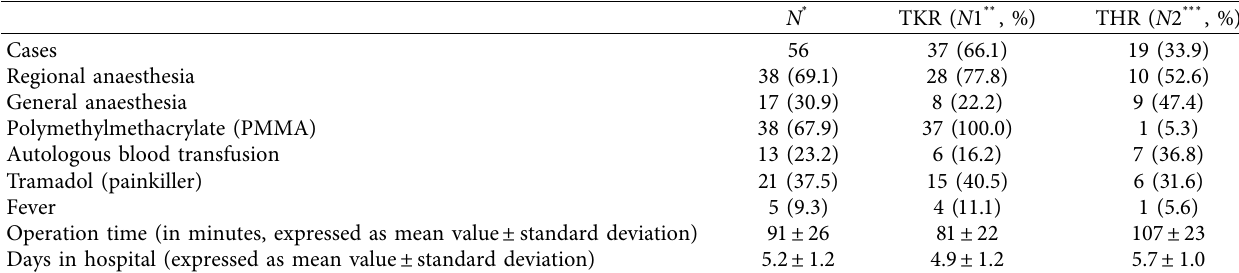
Table 4: Surgical parameters of the included population.